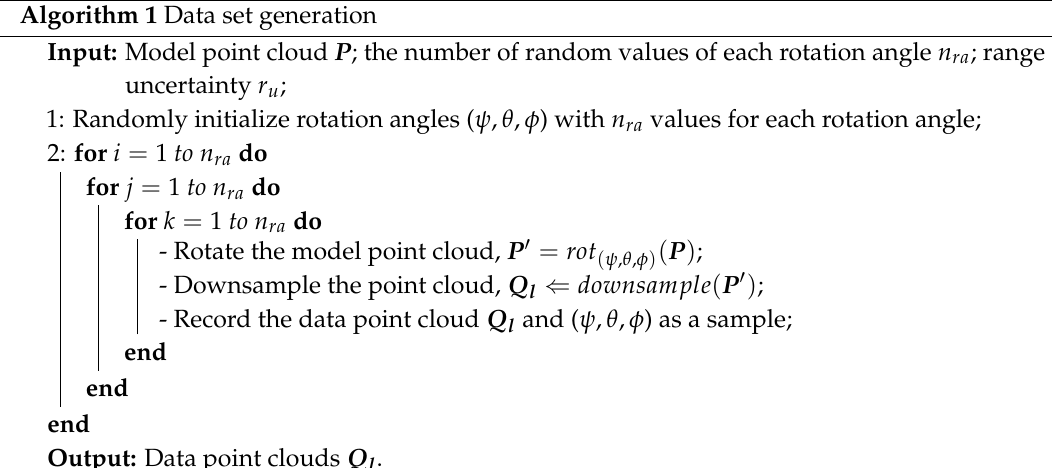
Algorithm 1 Data set